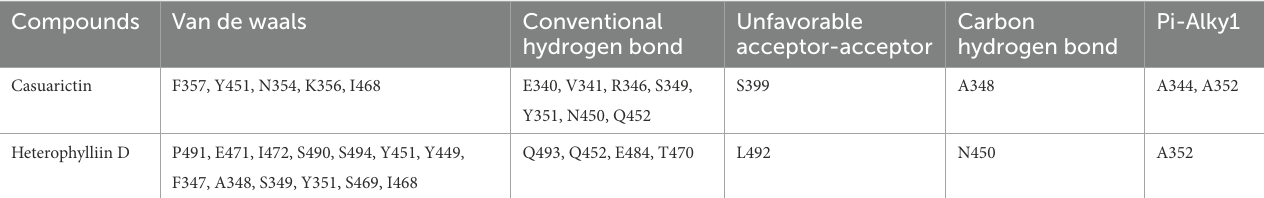
TABLE 5 The residues for the chemical bonds between compounds and spike proteins of Lambda